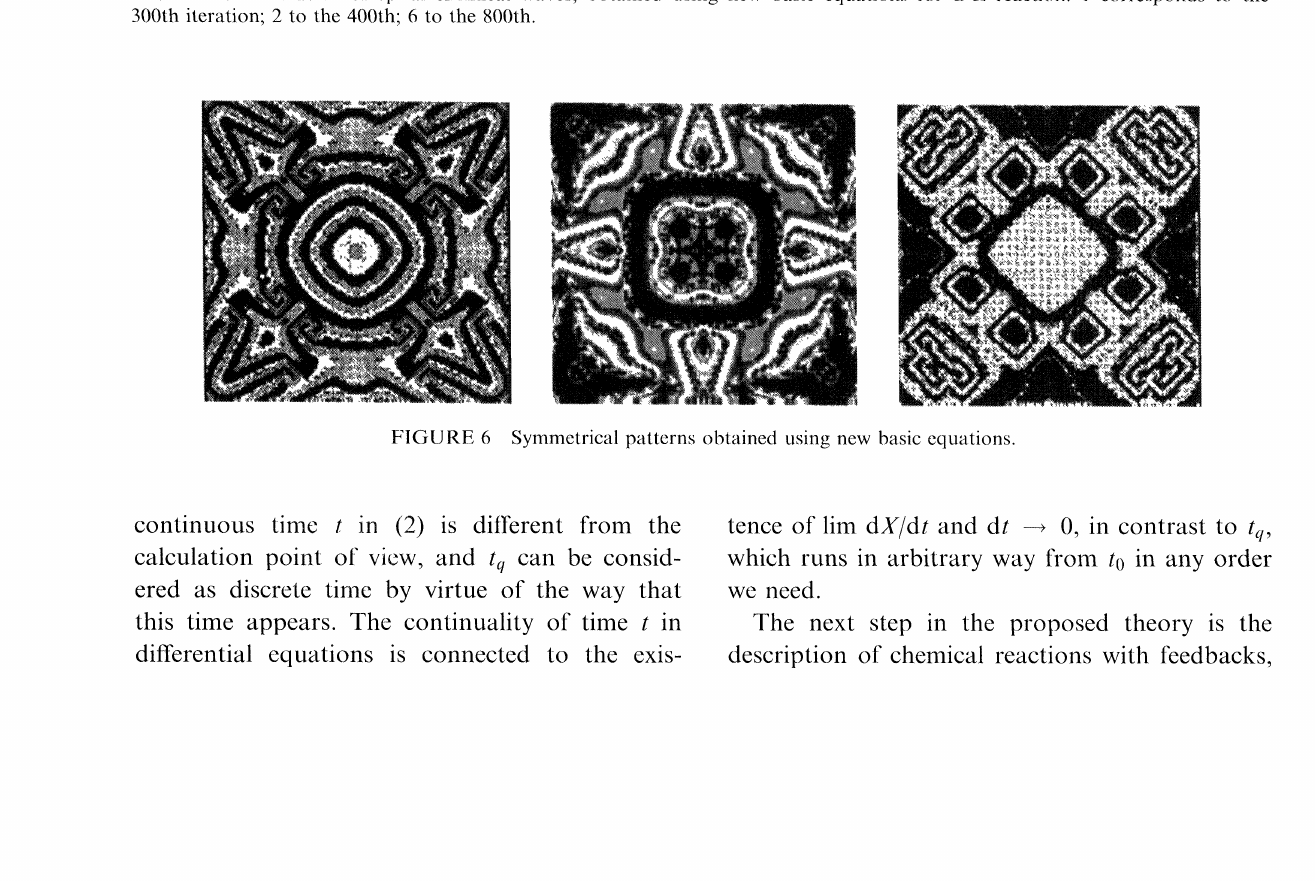
FIGURE 5 Evolution of spiral chemical waves, obtained using new basic equations for B-Z reaction: corresponds to the 300th iteration; 2 to the 400th; 6 to the 800th.